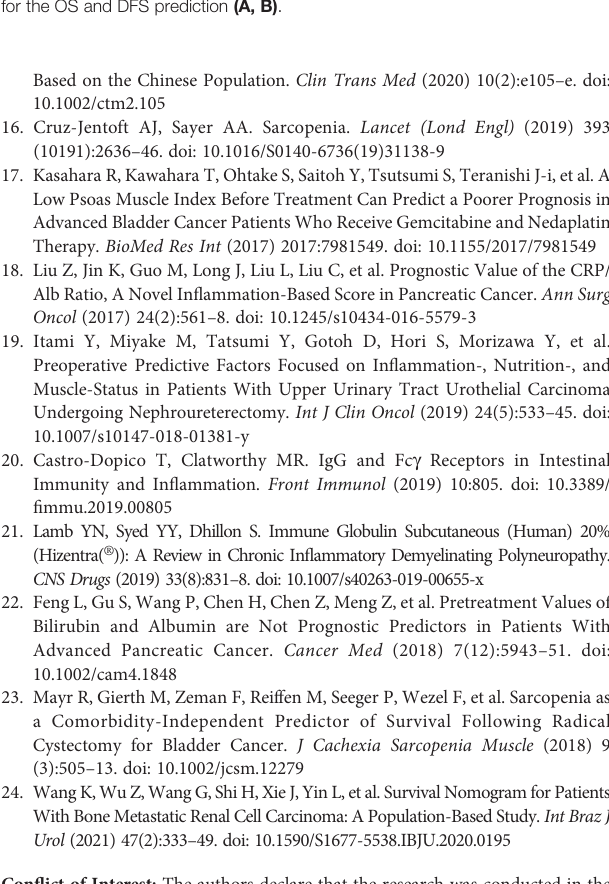
Supplementary Figure 1 | Calibration plot of the 3- and 5-year OS (A, C) and DFS (B, D) nomogram. Supplementary Figure 2 | ROC curves based on the nanogram for the 3- and 5- year OS and DFS prediction (A, B) . Supplementary Figure 3 | ROC curves based on the nanogram and TNM-stage for the OS and DFS prediction (A, B)